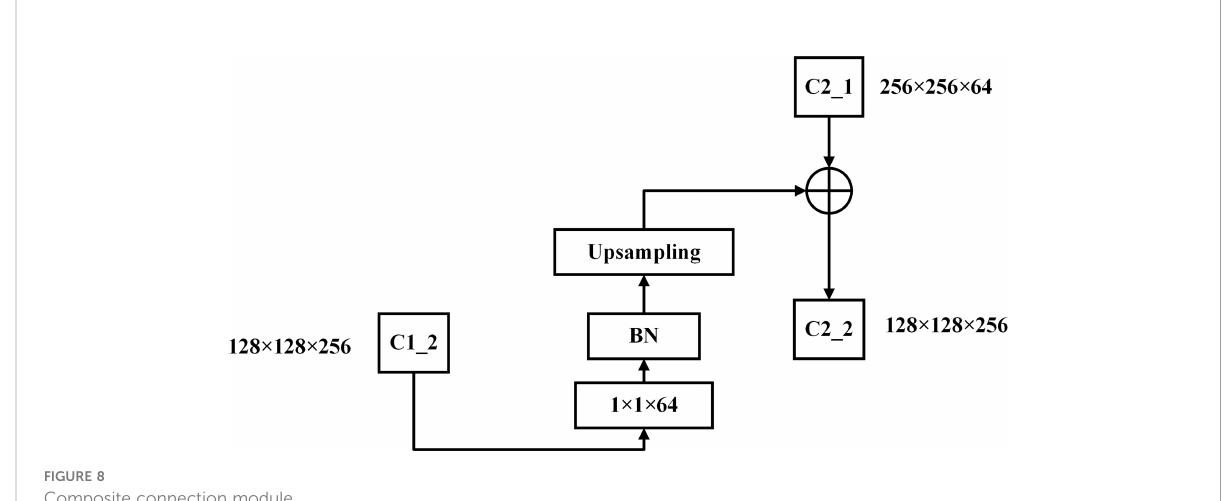
FIGURE 8 Composite connection